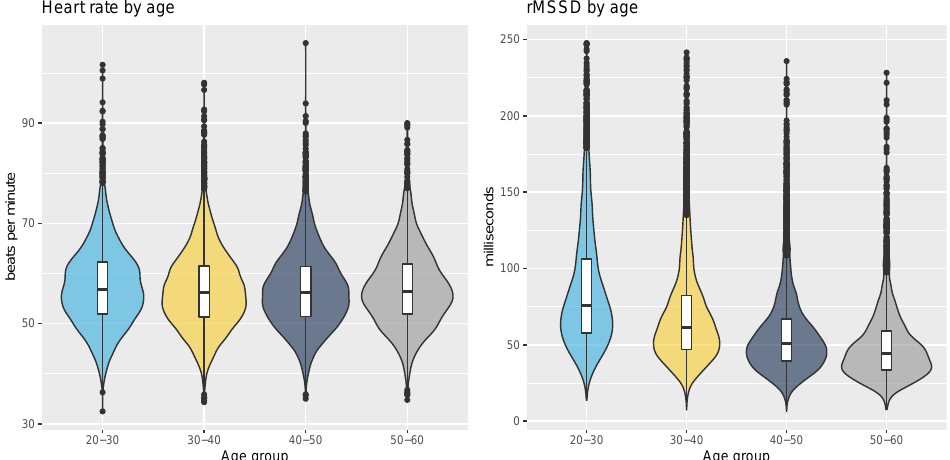
Figure 6. Relationship between heart rate, HRV and age by age group. Resting heart rate does not change across age groups while HRV is clearly reduced.